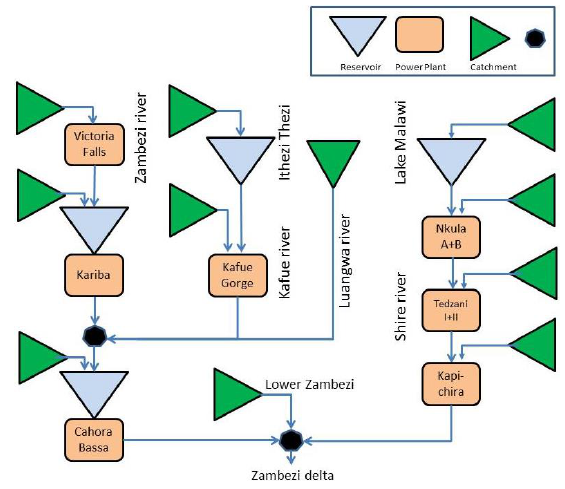
Figure 5. nMAG hydropower model setup for the Zambezi hydropower system.